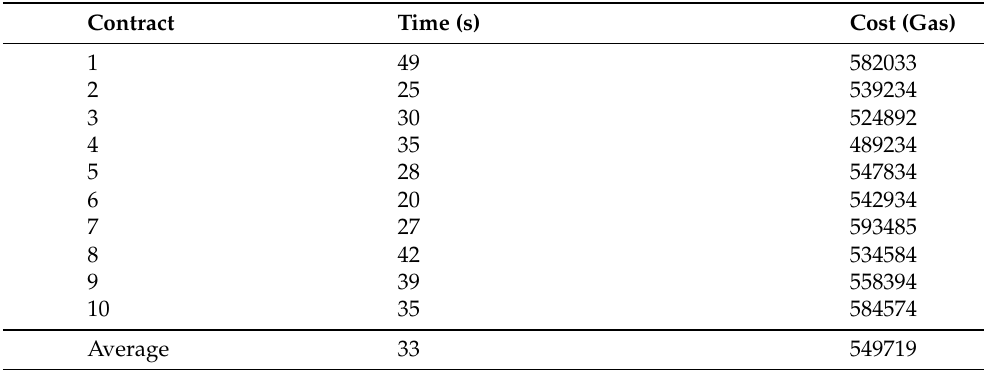
Table 3. Voter authentication: The average deployment time for 10 contracts and the associated costs are given for 30 experiments. The average of these contract deployment times is 33 s and the average cost is